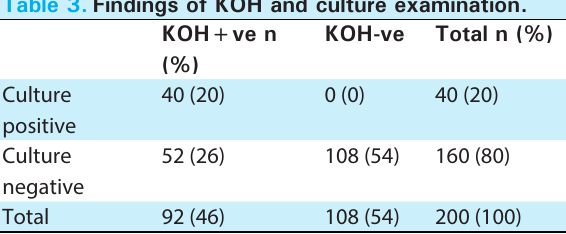
Table 3. Findings of KOH and culture examination.